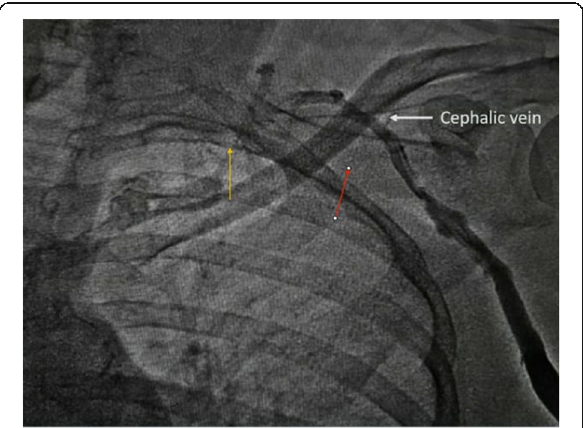
Fig. 2 Second intravenous contrast injection from the left brachial vein showing severe axillary and subclavian venous spasm (axillary and subclavian veins almost disappeared) with compensatory dilatation of cephalic vein due to increased venous flow